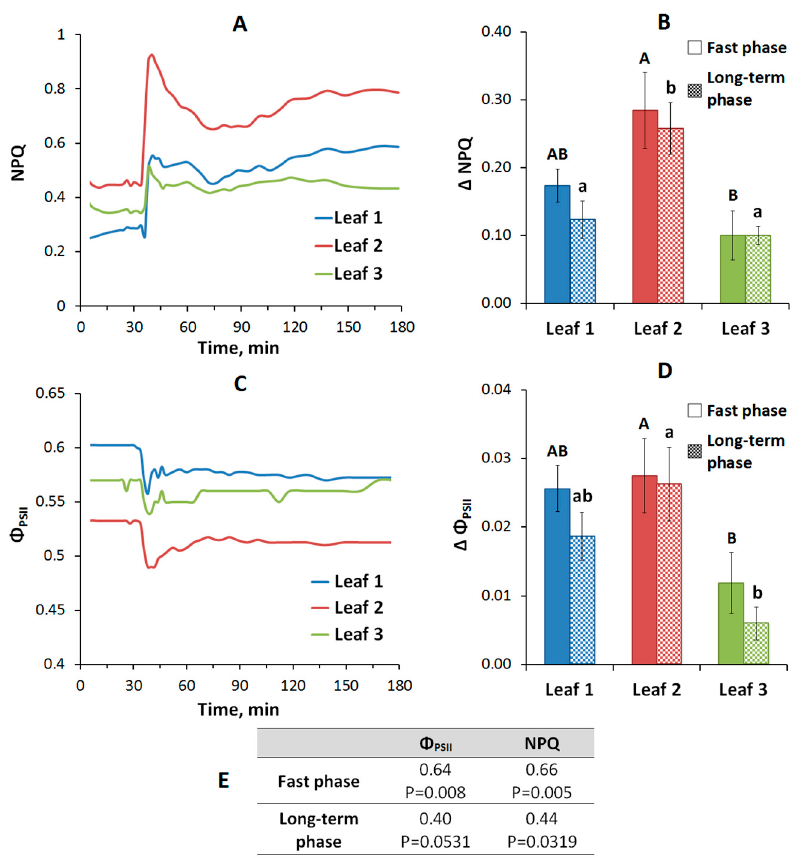
Figure 3. Changes in photosynthesis activity induced by variation potential (VP) in the first, second and third leaves, located below the stimulated leaf: ( A ) the typical records of non-photochemical quenching (NPQ) changes in the first, second and third leaves; ( B ) amplitudes of NPQ changes in the first, second and third leaves; ( C ) the typical records of Φ PSII changes in the first, second and third leaves; ( D ) amplitudes of Φ PSII changes in the first, second and third leaves; ( E ) correlations between the amplitude of the photosynthesis response and the VP amplitude. Correlations were determined for simultaneous recording of electrical signals and photosynthesis responses on separate plants (n = 8). Different uppercase letters denote significant differences between columns of fast phase, different lowercase letters denote significant differences between columns of long-term phase, p < 0.05.